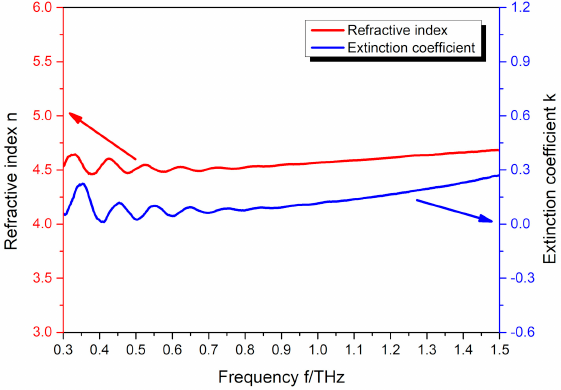
Figure 2. Complex refractive index of the top coat.